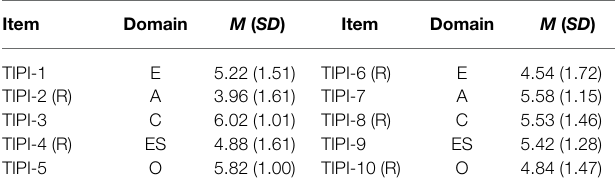
TABLE 3 | Descriptive statistics for the N-TIPI items.